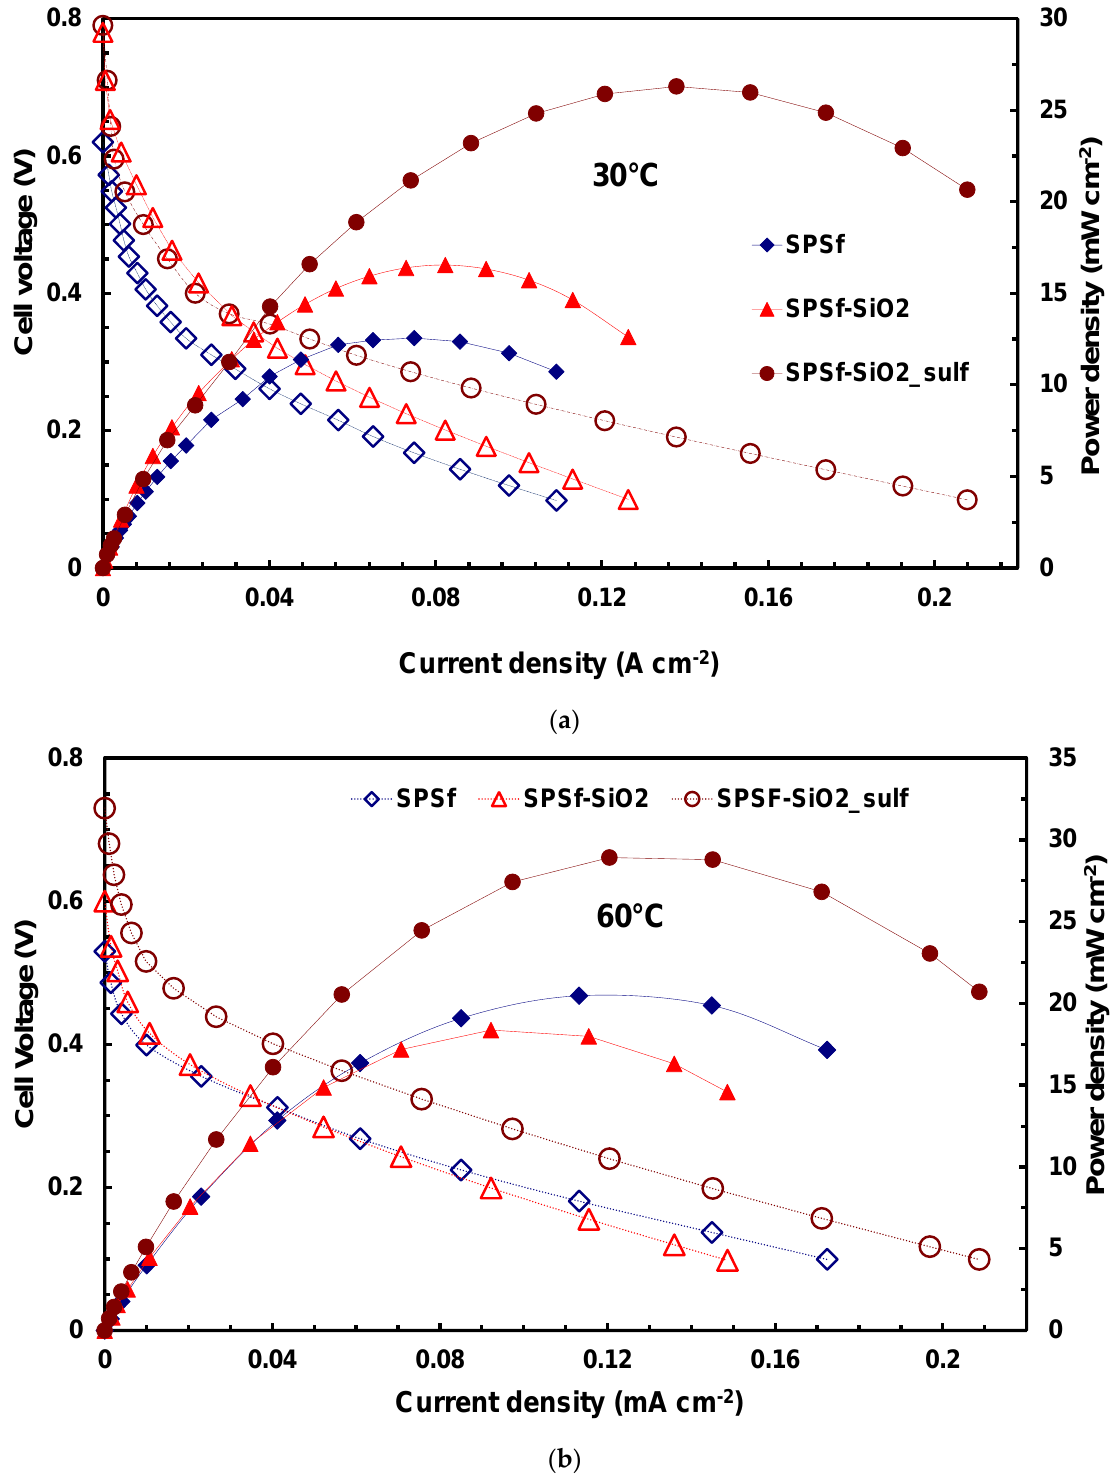
Figure 4. Polarization and power density curves of different polysulfone membranes at ( a ) 30 °C and ( b ) 60 °C and 5 M MeOH.